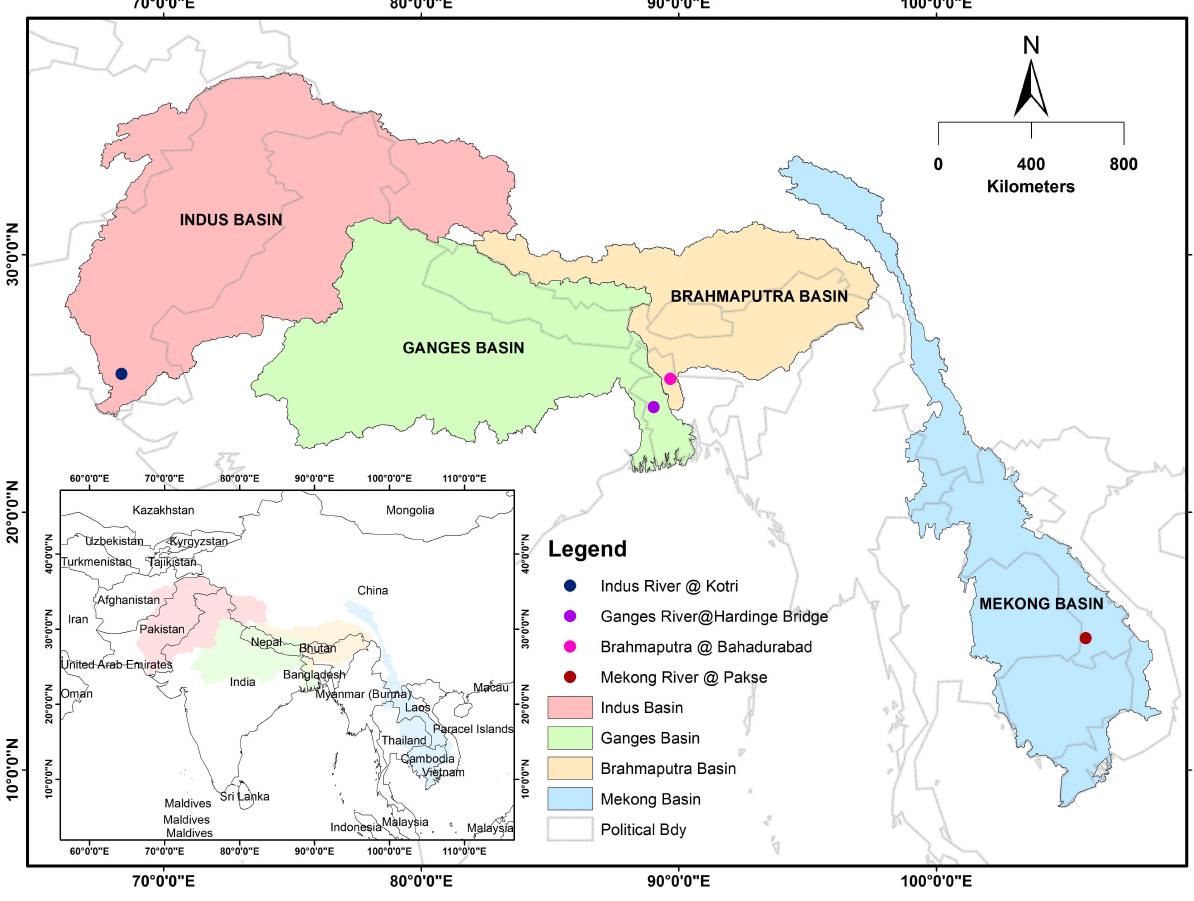
observations of precipitation and river discharges.